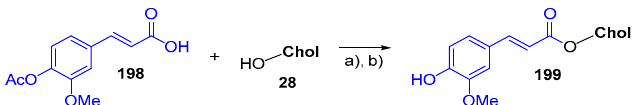
Scheme 47. Synthesis of cholesterol-based steryl ferulate. Reagents and conditions: a ) DCC, DMAP,